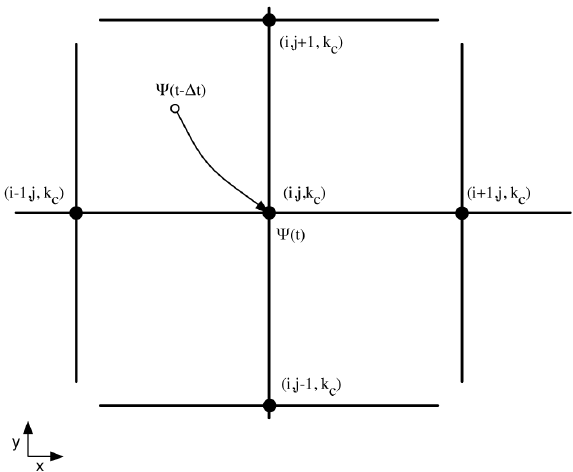
Figure 3. Basic principle of the semi-Lagrangian method explained in the cold ice grid. If the value of 9(t − 1t) at the departure point (open circle) is known, the value 9(t) at the desired grid point ( i,j,k c ) can be calculated, where i and j are the indices of the hori- zontal grid and k c the one for the vertical sigma coordinates in cold